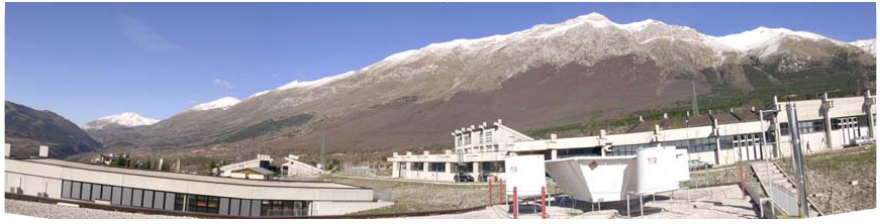
Fig. 2. Picture of the Assergi site. The wind profiler is located on the top of one building of the National Laboratory of Gran Sasso (LNGS), as visible in the picture, at an altitude of 981 m ASL. The picture is taken looking toward the North – North-East direction.